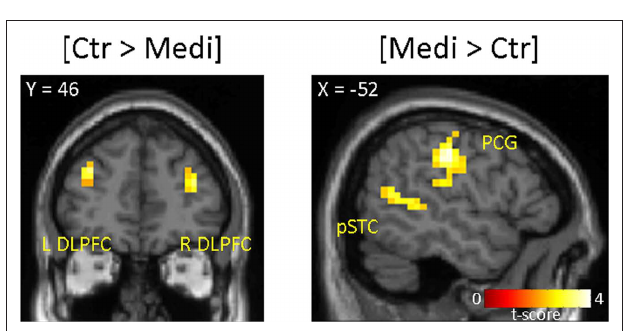
FIguRe 5 | Comparison between a subset of participants that play the ultimatum game like rational agents ; controls ( n = 9) and meditators ( n = 14). The main effect [Controls > Meditators] display elevated activity in bilateral DLPFC, whereas in the opposite contrast [Meditators > Controls] the left postcentral gyrus (PCG) and left posterior superior temporal cortex (pSTC) are